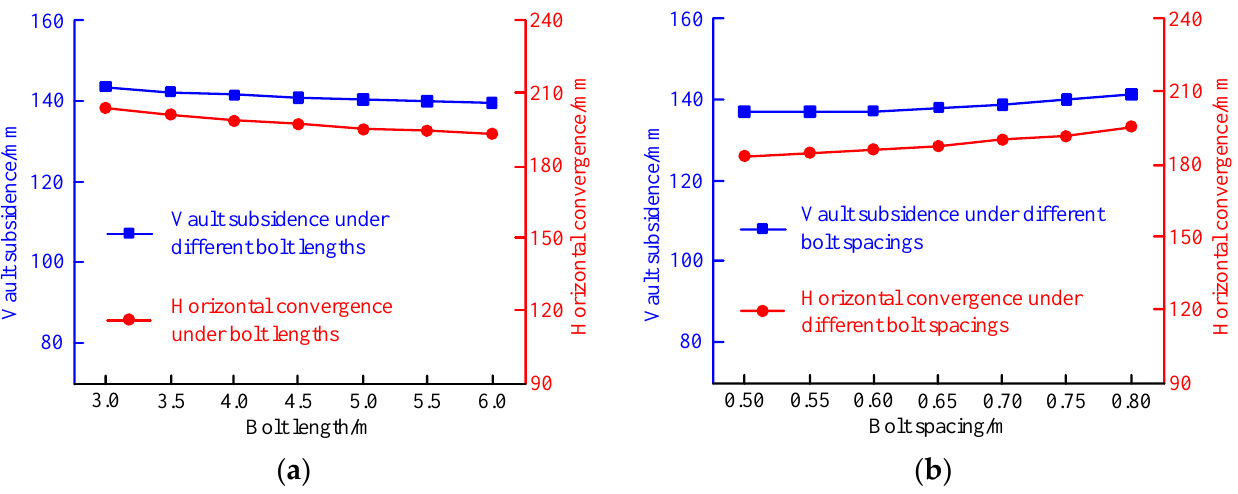
Figure 8. ( a ) Tunnel deformation curves under different bolt lengths and ( b ) tunnel deformation curves under different bolt spacings. Tunnel deformation curves under different bolt parameters.